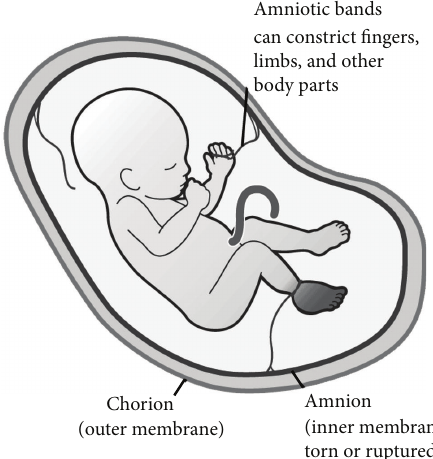
Figure 10: Amniotic band